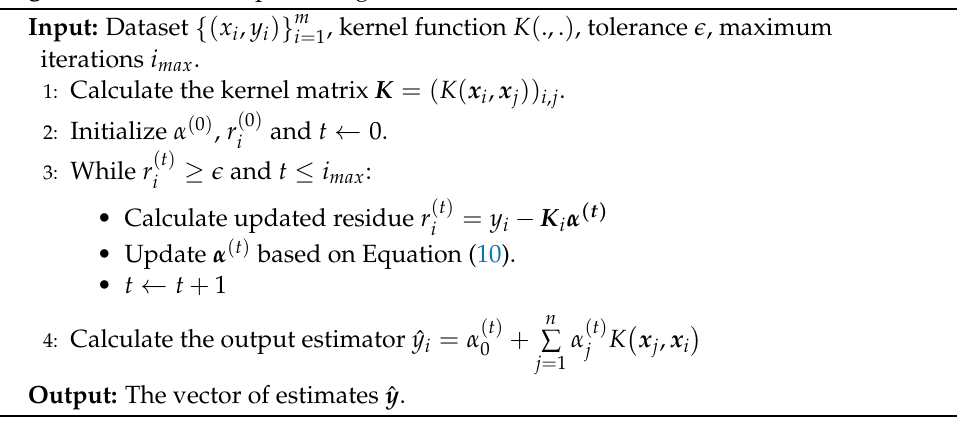
Algorithm 2: Kernel expectile regression